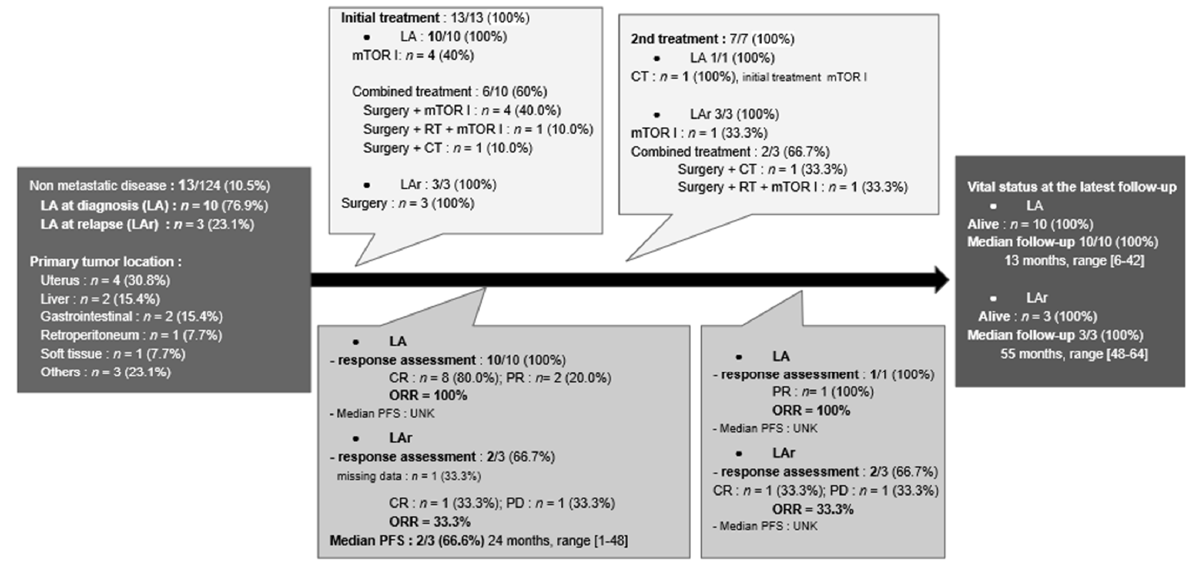
Figure 3. Flowchart of the management for locally advanced PEComas. Abbreviations: CR: complete response as defined by RECIST 1.1 criteria; CT: chemotherapy; DOD: dead of the disease; I: inhibitors; LA: locally advanced at diagnosis, LAr: locally advanced at relapse; ORR: objective response rate; PFS: progression free survival; PR: partial response; RT: radiotherapy; and UNK: unknown.